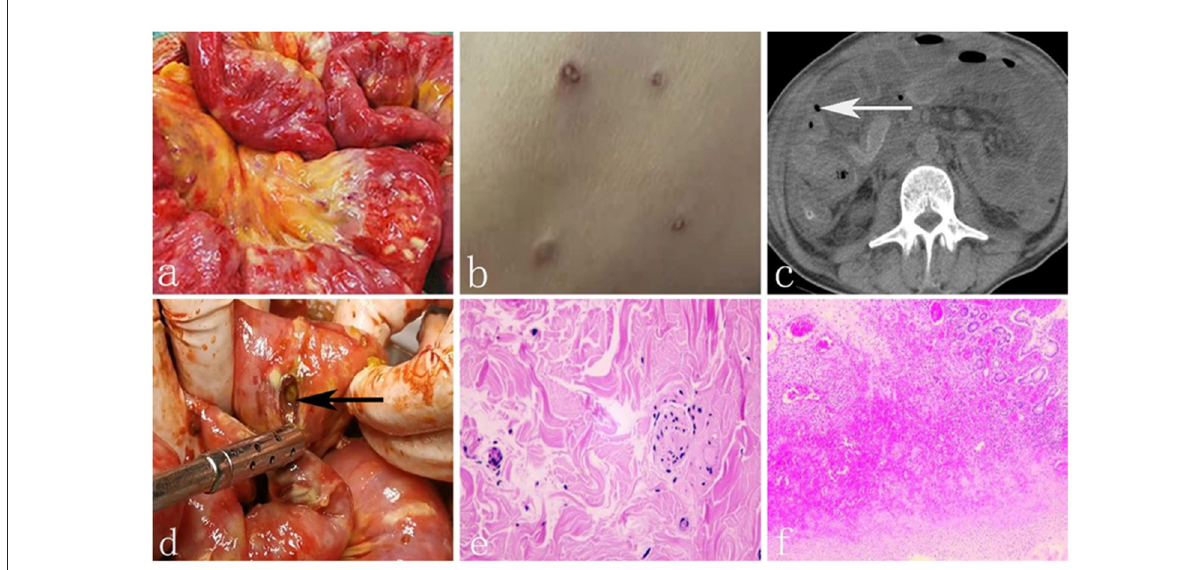
FIGURE1 (a) Numerous yellow-white tubercles were interspersed on the surface of small intestine. (b) Generalized skin emption with porcelain - white centers surrounded by erythematous borders. (c) The white arrow shows free air around the intestine. (d) The black arrow shows one of the perforations of the small intestine. (e) The biopsy of skin eruption showed atrophy of epidermis, hyperplasia and collagen of dermal fibrous tissue. (f) Histopathologic result of the resected intestine showed acute and chronic inflammatory cell